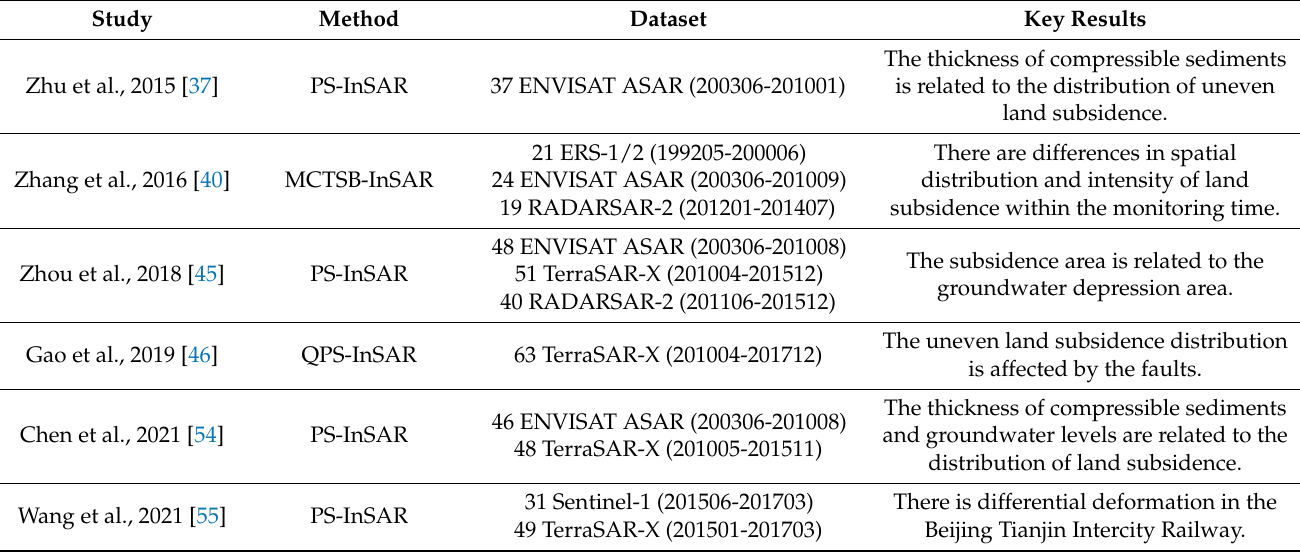
Table 1. Representative studies of Beijing land